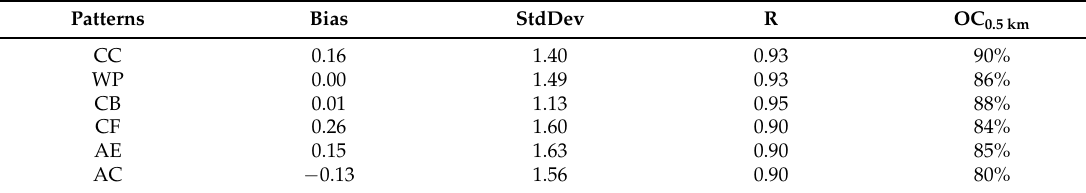
Table 1. Comparisons of cloud-base height retrieved from the radiosonde and ARSCL data under six synoptic patterns in terms of the mean bias (units in km), the standard deviation (StdDev; units in km), the correlation coefficient (R), and the occurrence frequency of the absolute differences of cloud base-heights less than 0.5 km for the two methods (OC 0.5 km ).